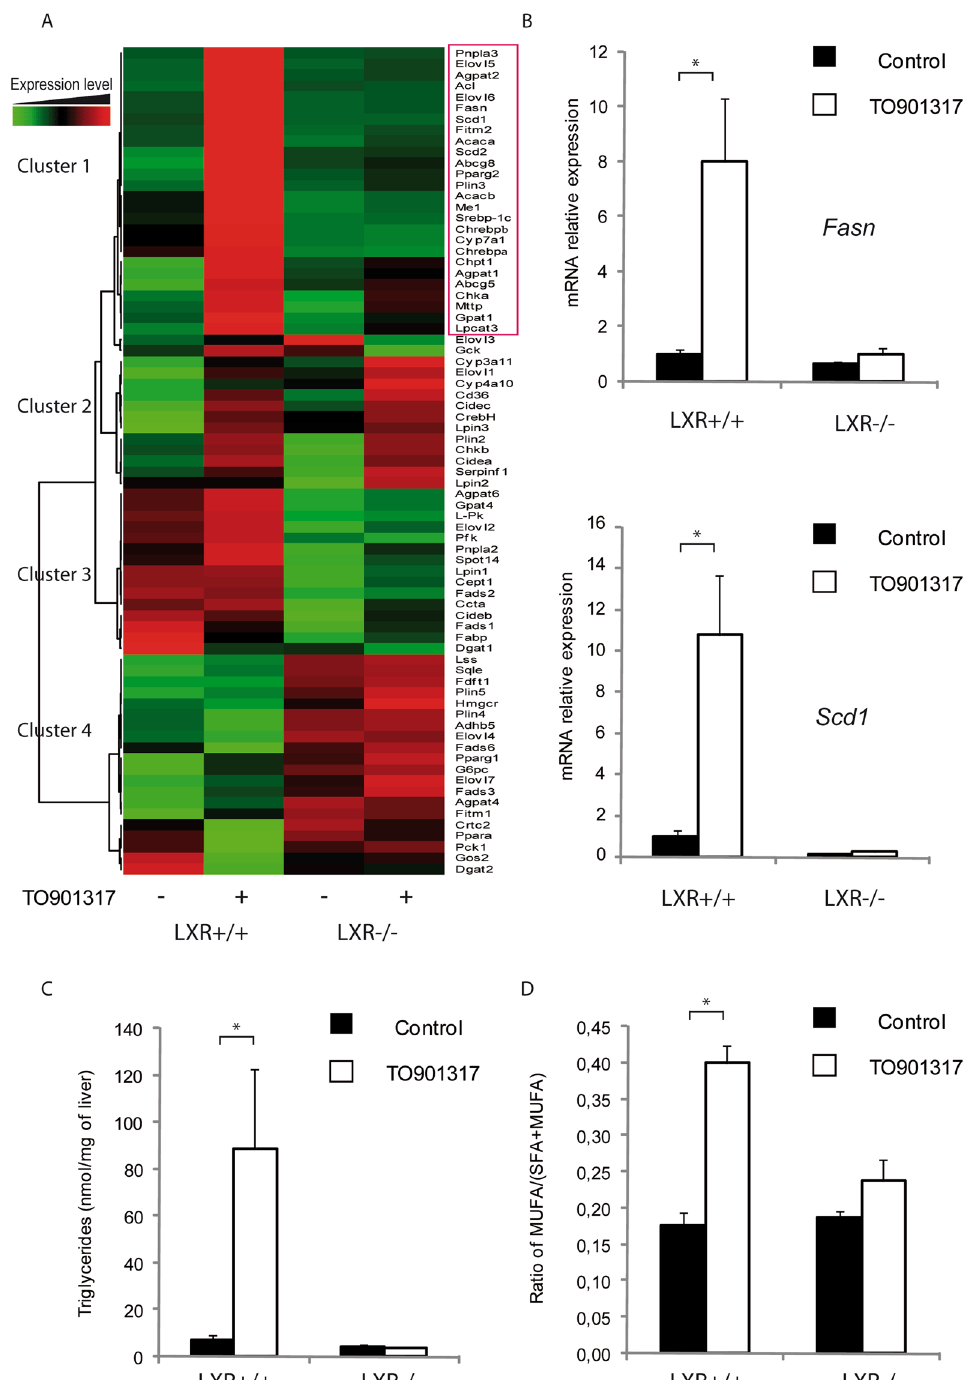
Figure 5. Trizol extraction of both hepatic mRNA and lipids allows detection of changes in gene expression and liver lipids in mice treated with T0901317. ( A ) Hierarchical classification coupled with a heatmap of hepatic gene expression. mRNA levels (74 genes related to lipid metabolism) measured by qPCR. We identified four clusters of genes differentially regulated in response to genotype or LXR activation. ( B ) Fas and Scd1 mRNA quantification by qPCR. ( C ) Liver triglycerides and the ratio of hepatic mono-unsaturated fatty acids (MUFAs) to saturated fatty acids (SFAs) + MUFAs were analyzed by gas chromatography. Data are presented as means ± s.e.m. LXR + / + and LXR − / − mice were treated with vehicle or T0901317 (n = 5 mice per group). * P < 0.05 for the effect of T0901317 on the same